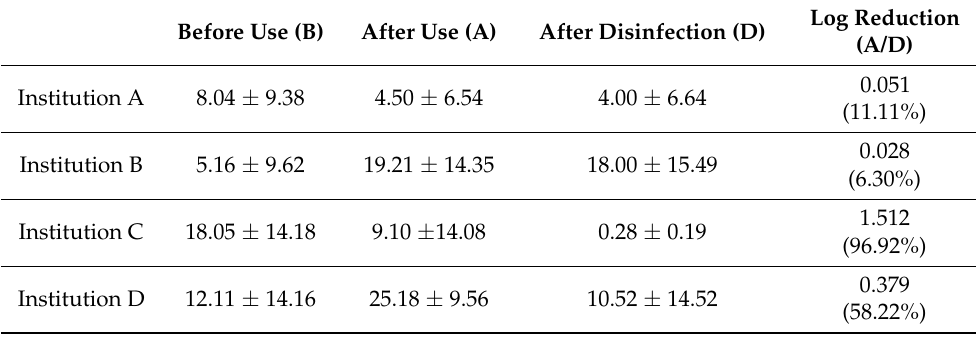
Table 1. Average CFU/cm 2 values across institutions, sampled on three different occasions: before use, after use, after disinfection, and after log reduction (A/D). Before Use (B) After Use (A) After Disinfection